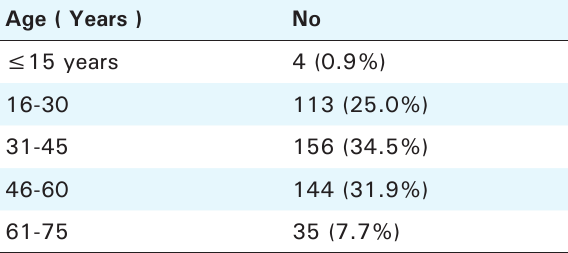
Table 2. The age group of recipients